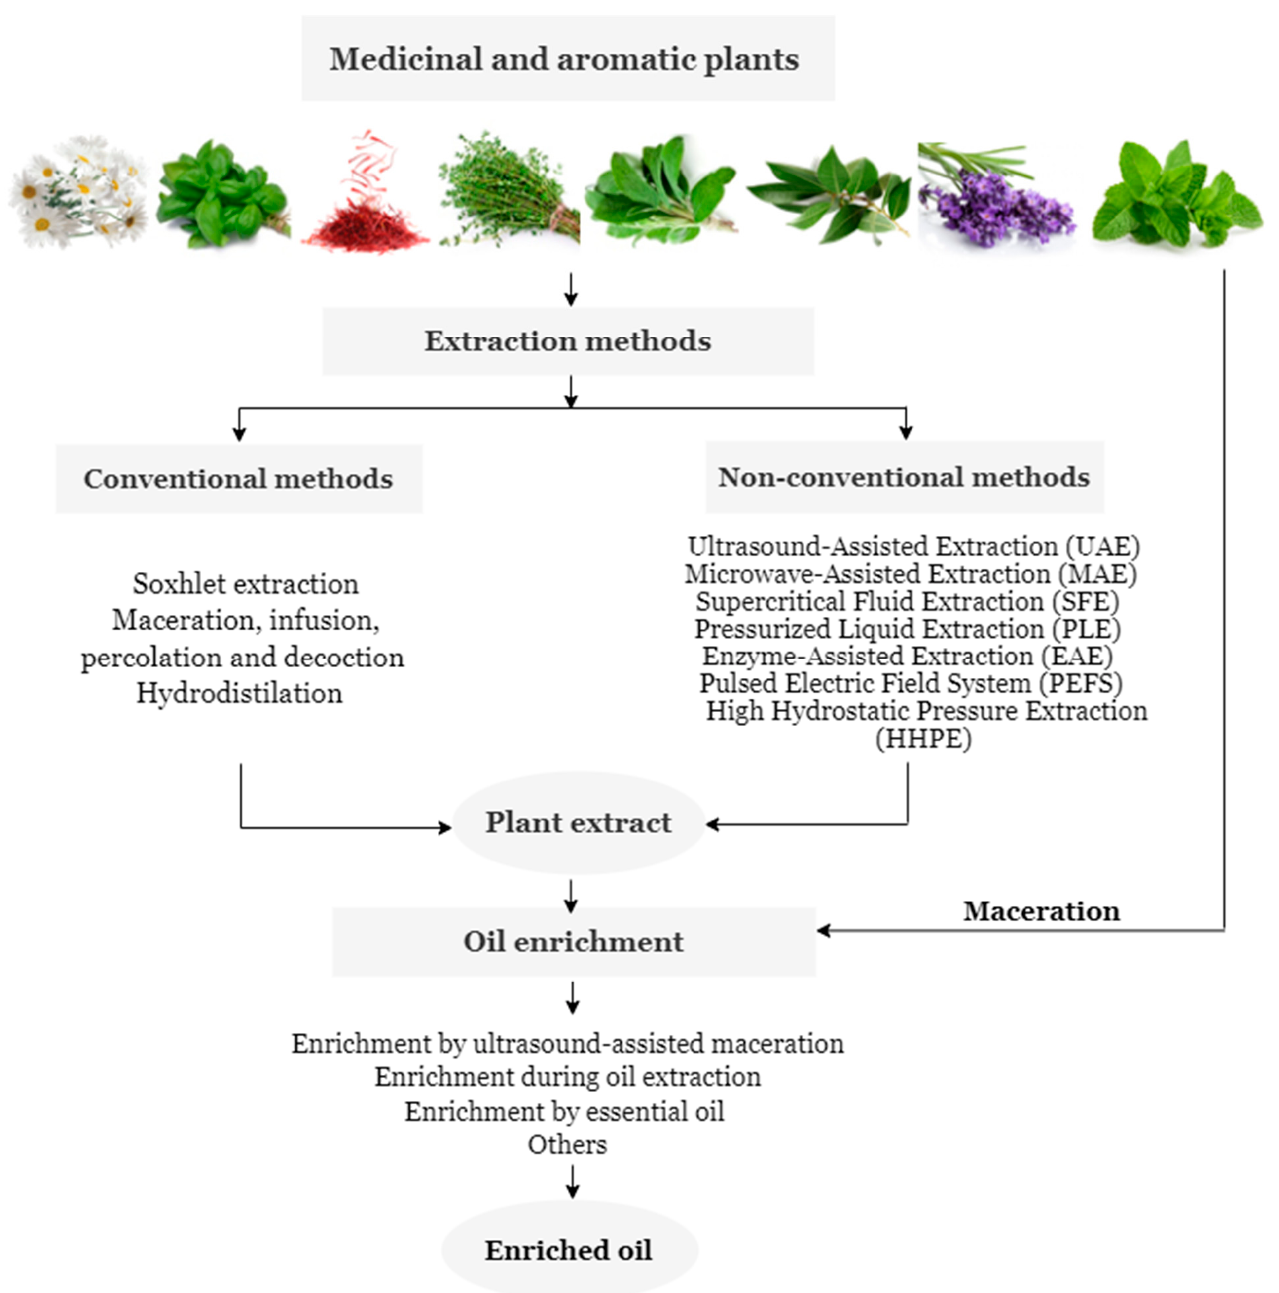
Figure 14. Extraction and enrichment methods of antioxidants from MAPs.